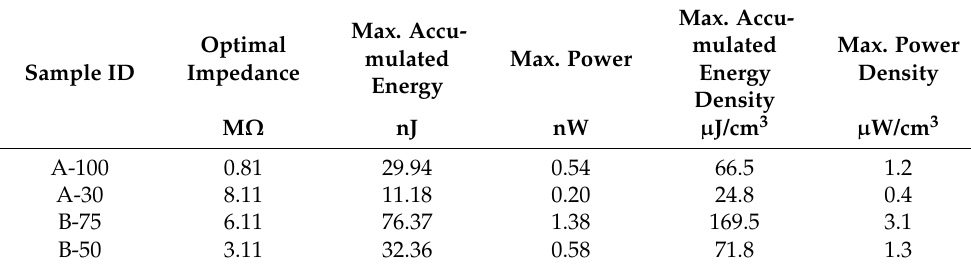
Table 4. Piezoelectric energy generation parameters obtained from measurements of voltage gener- ated by the